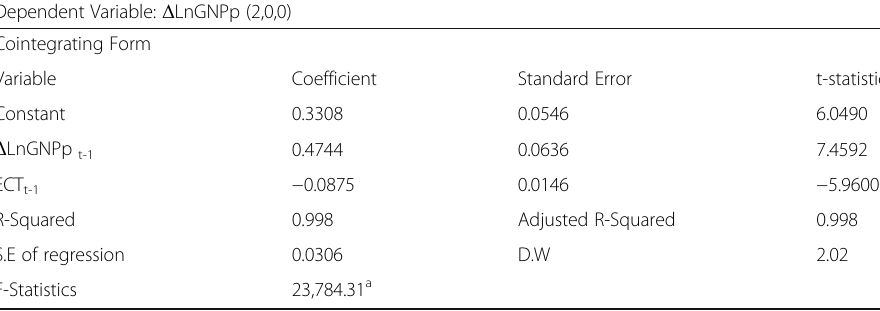
Table 5 ARDL Short-run Results